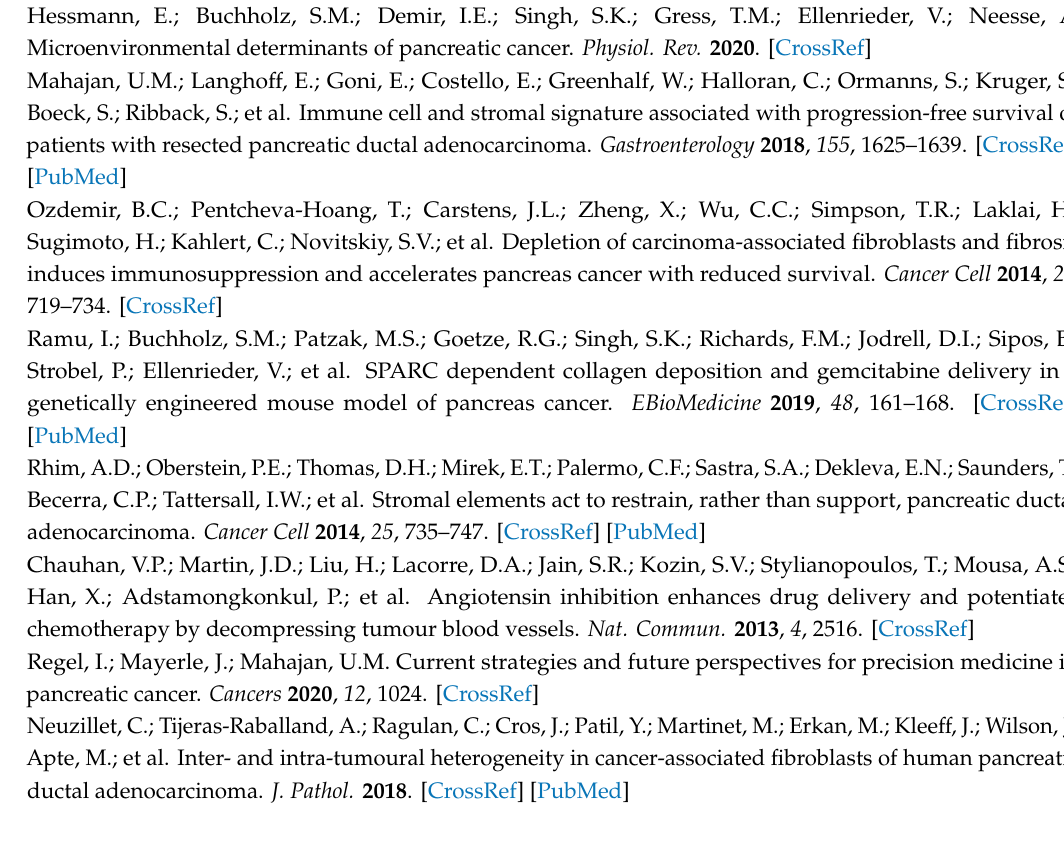
Figure S1: MTT assay with conditioned media (CM) of human THP-1 cells or murine BMDM. Figure S2: MTT assay with conditioned media 24 h preincubated with gemcitabine or fresh gemcitabine. Figure S3: qRT-PCR for M1 and M2 markers in THP-1 macrophages. Figure S4: 10 days treatment schedule for tumor bearing KPC